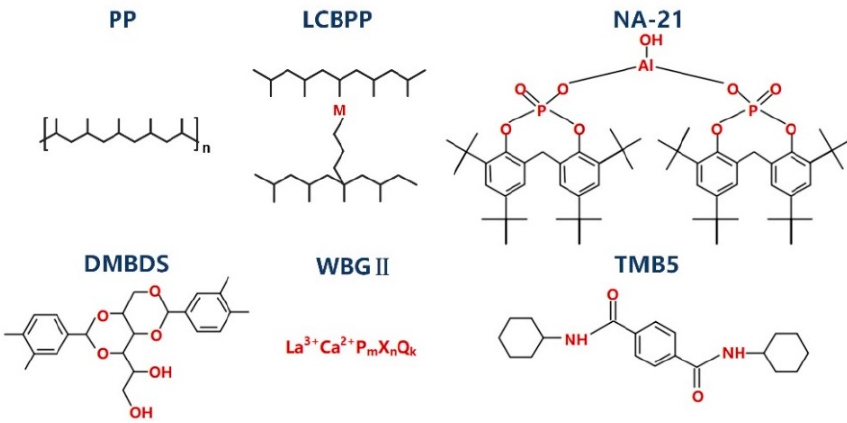
Figure 1. Molecular structure of PP, LCBPP and nucleating agents. Table 1. Test samples with different nucleating agents.